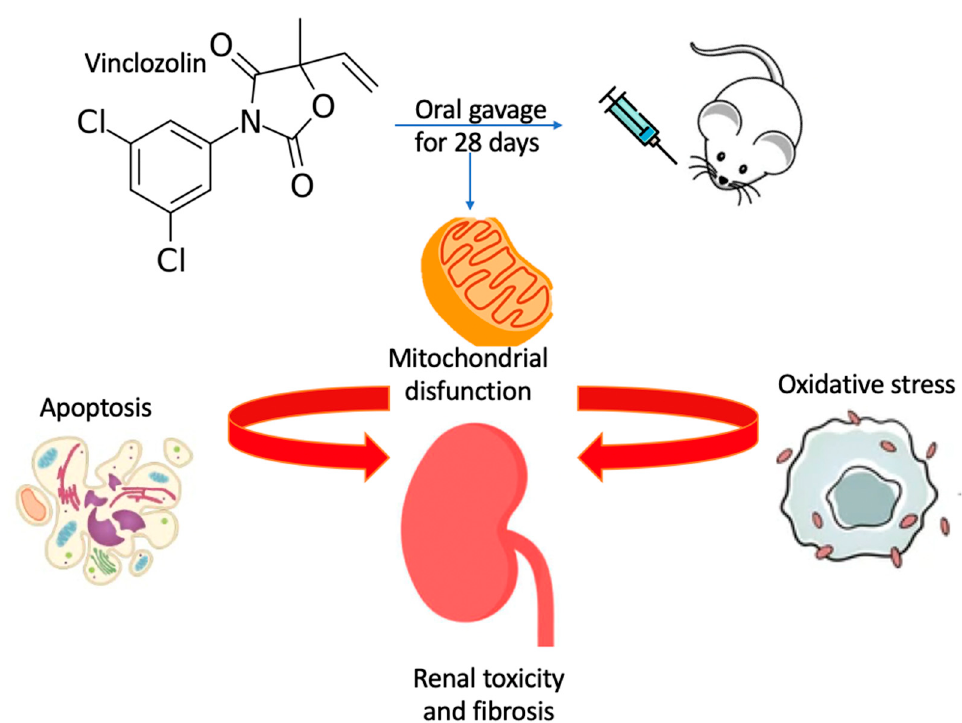
Figure 10. Schematic representation of the proposed signal network.